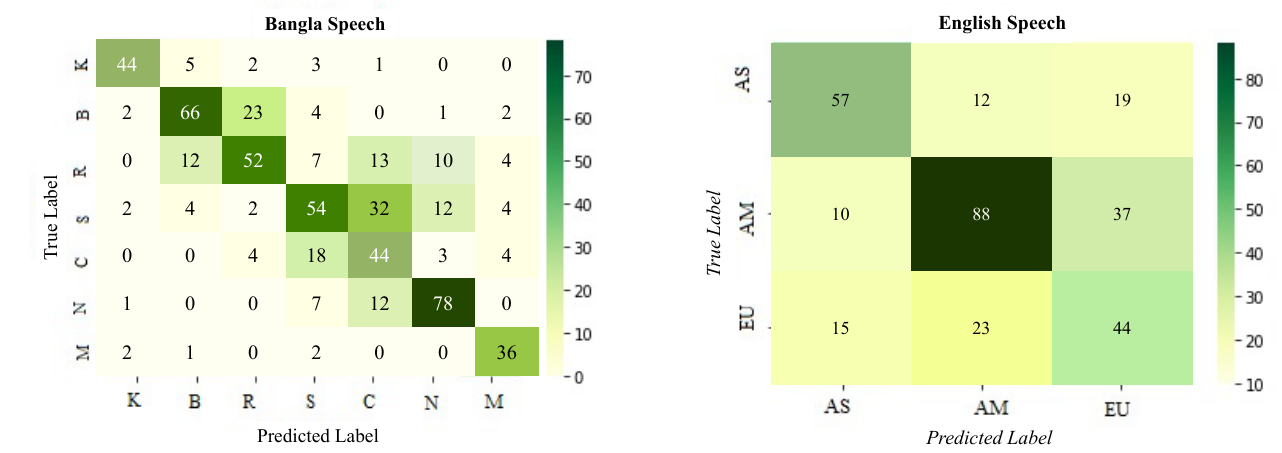
Figure 6. Confusion matrices of dialects for Bangla and English